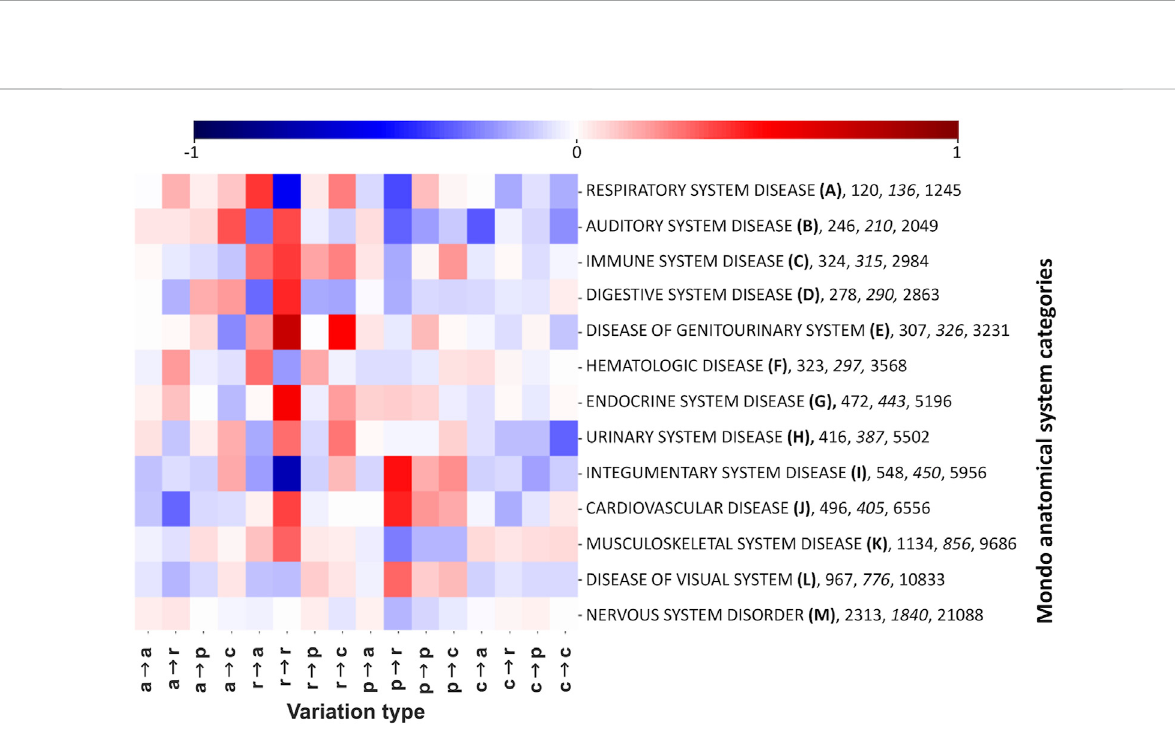
FIGURE 4 Log-odd scores of variation types associated to the different Mondo anatomical system categories. The heatmap shows the log-odd score of eachvariationtypewithrespecttothecorrespondingLP/Pbackground(showninSupplementaryFigureS1).ForeachMondocategory,weshowthe number of diseases, genes (italic) and disease related variations. In variation types, labels are as follows: a, nonpolar; r, aromatic; p, polar; and c, charged.Thelog-odd valuesareaffectedbyarelativeerrorlowerthan5%,asestimatedwithabootstrappingprocedure.Statisticalvalidationof the and resulting FDR-corrected p -values are reported in Supplementary Table